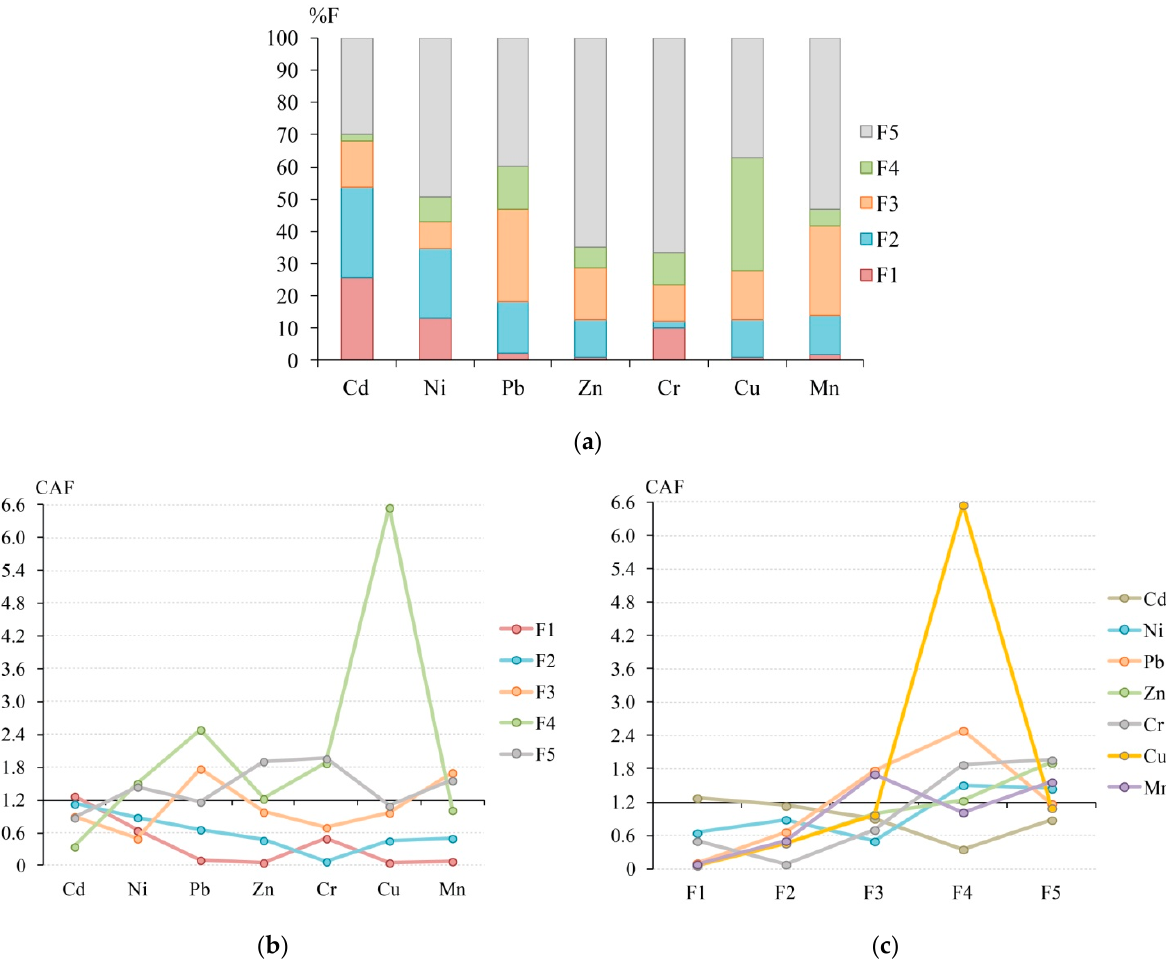
Figure 1. The fractionation distribution of HMs ( a ), levels of chemical affinity factor (CAF) for HMs ( b ), and levels of CAF for chemical fractions ( c ) in agricultural soils from Dongdagou stream basin, China—calculated from the data of Y. Li et al. [86]. F1 is exchangeable, F2 is carbonate, F3 is reducible (Fe-Mn oxyhydroxides), F4 is organic, F5 is residual fraction